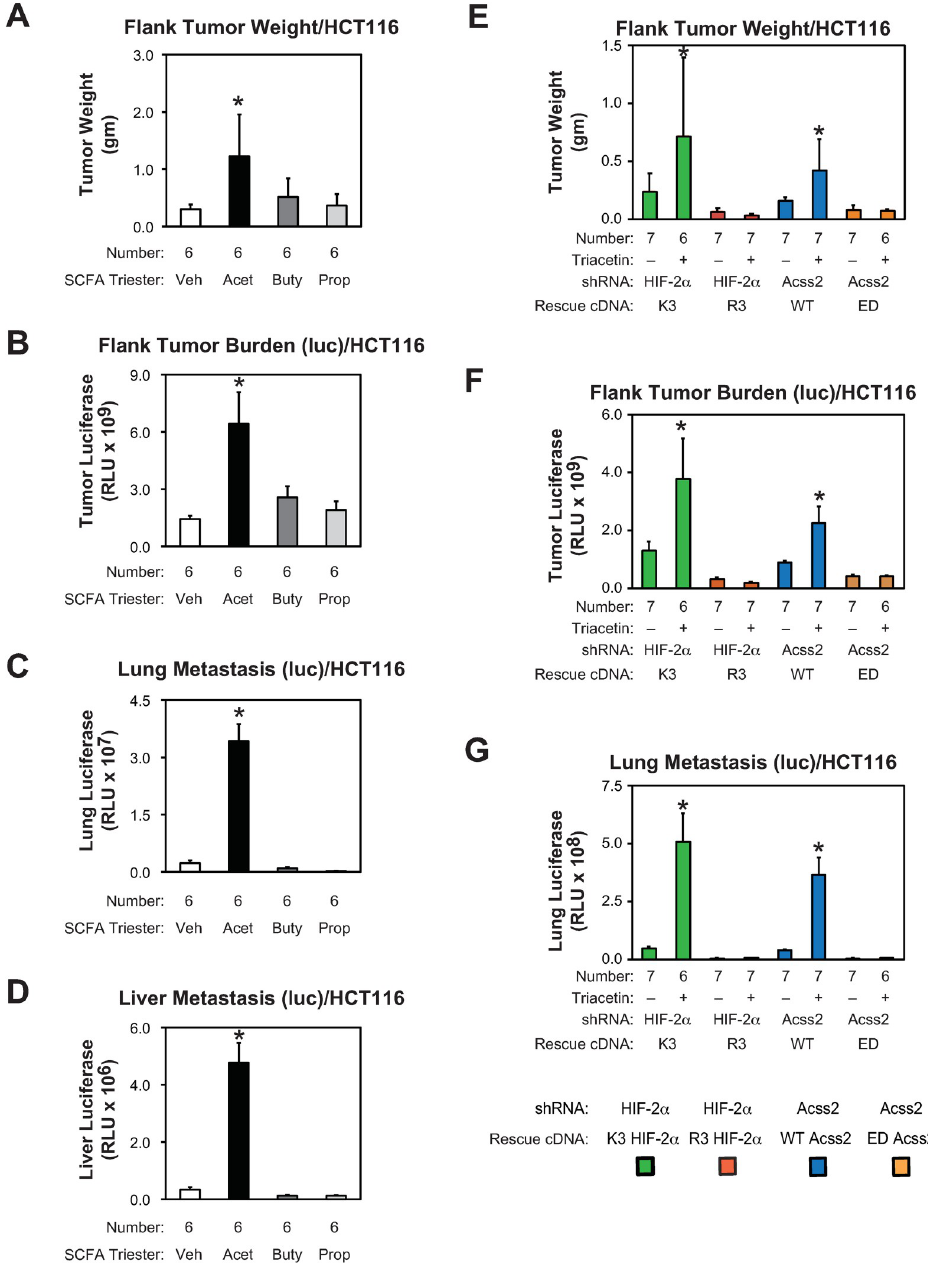
Fig 9. Acetate-augmented HCT116 tumor growth requires Acss2/HIF-2 α . (A) Primary tumor weight as well as (B) primary tumor, (C) lung, and (D) liver metastatic burden in nude mice carrying flank tumors derived from luciferase- expressing stably transformed control knockdown HCT116 cells treated by oral gavage with control or acetate (Acet; triacetin), butyrate (Buty, tributyrin), or propionate (Prop; tripropionin) tri-ester (n = 6/treatment). (E) Primary tumor weight as well as (F) primary tumor, and (G) lung metastatic burden in nude mice treated by oral gavage with control or acetate carrying flank tumors derived from luciferase-expressing stably transformed HIF-2 α knockdown HCT116 cells rescued with wild-type (K3) or arginine-lysine substituted mutant (R3) HIF-2 α , or stably transformed Acss2 knockdown HCT116 cells rescued with wild-type (WT) or cytosol-restricted mutant (ED) Acss2 (n = 6 or 7/ treatment). Luciferase activity was assessed by triplicate measurements of tissue extracts. Comparison within each shRNA knockdown/control rescue pair treated with vehicle or acetate (triacetin) was performed by one-tailed unpaired t test with Welch’s correction for groups of equal sample size or by one-tailed Mann-Whitney test for groups of unequal sample size with reductions indicated ( � , P < 0.05). Values indicated are means with SD (weights) or SEM (luciferase